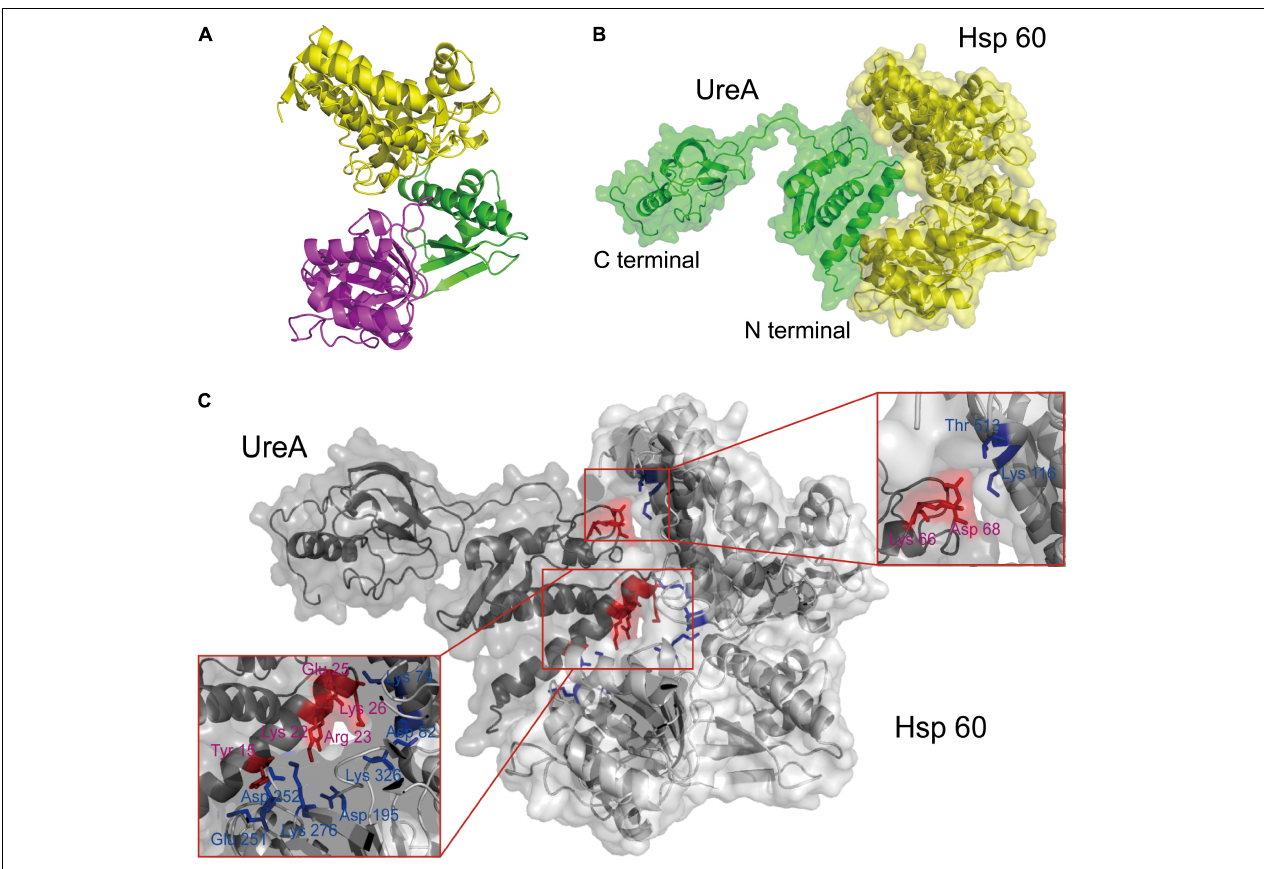
FIGURE 4 | The interaction analysis between UreA and Hsp60 by molecular docking. (A) Structure of the constructed Hsp60 monomer from H. pylori based on E. coli GroEL (PDB: 2YNJ). (B) The interaction model of UreA (PDB: 1E9Z) and Hsp60 established by molecular docking. (C) Interfaces and key residues analysis. Residues on UreA participating in the interaction are colored in red and noted with purple words. Residues on Hsp60 participating in the interaction are colored and noted in